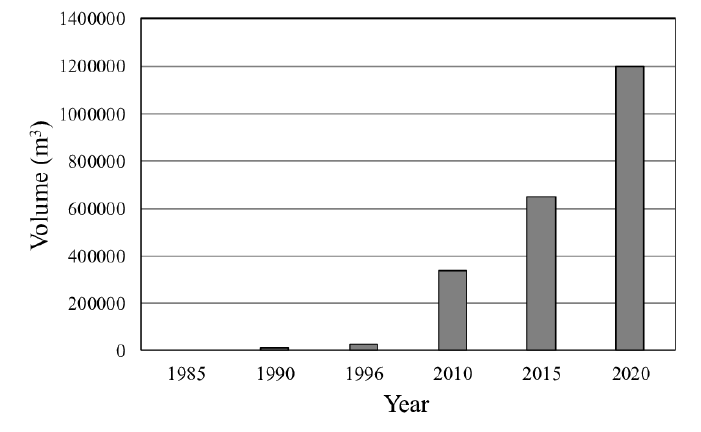
Figure 1. Example of a cross laminated timber panel [6].